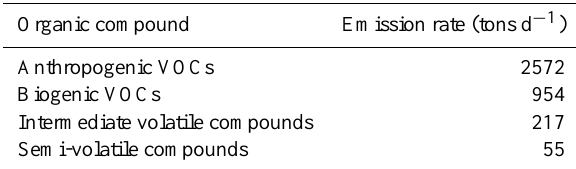
Table 1. Organic compound emission rates (tons d − 1 ) over the modeling